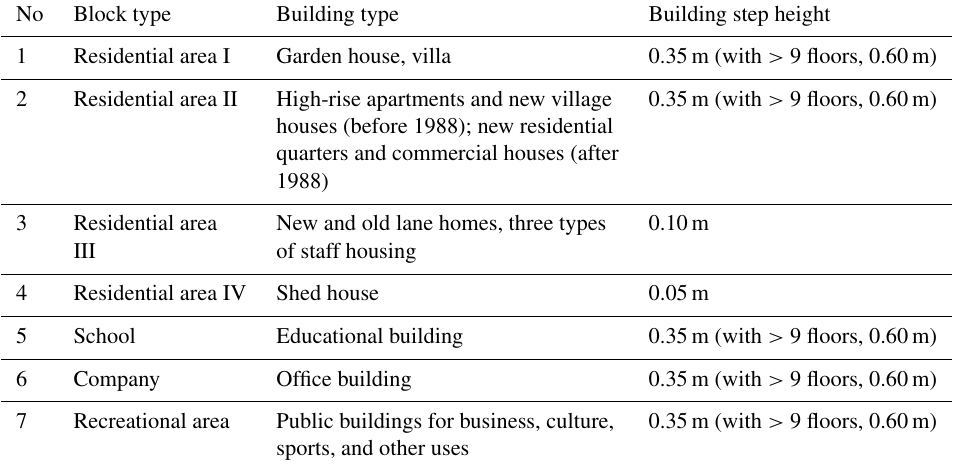
Table 5. Building step heights for different block types.